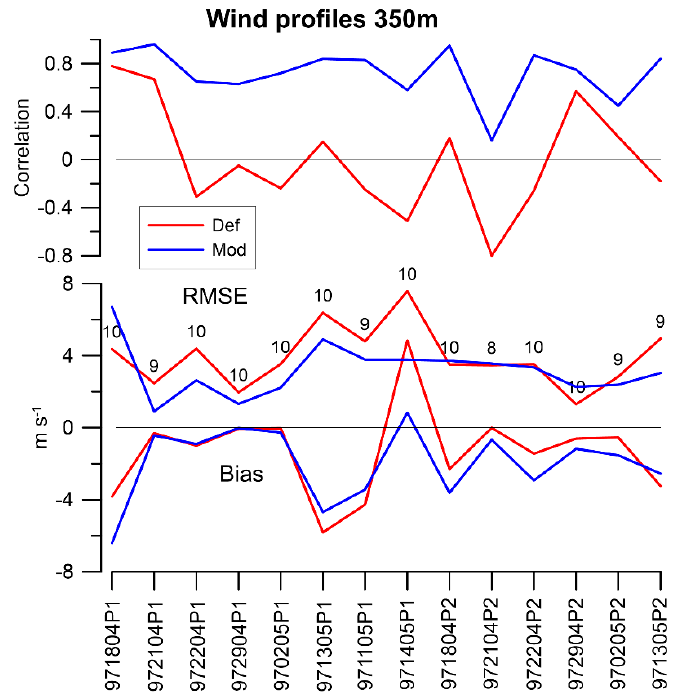
Figure 11. Statistics of the comparisons of simulations (def: red, mod: blue) with aircraft profiles for all KABEG flights for wind speed below 350 m ( x axis: date (YYDDMM) and profile (P1/P2)). Lower panel : Bias and RMSE (number of values indicated). Upper panel : Correlation.